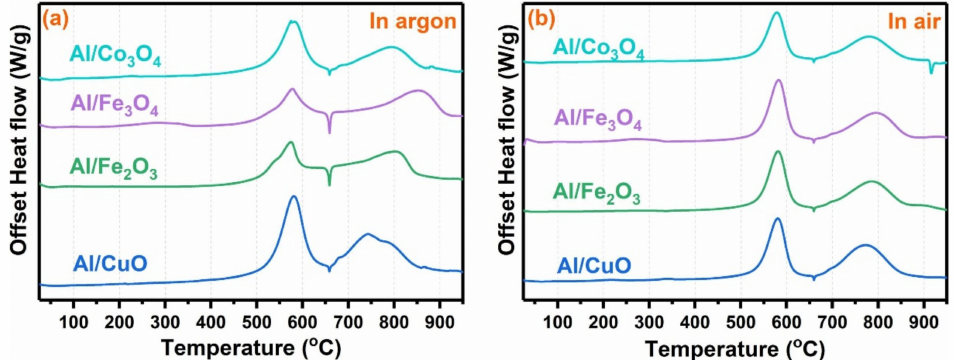
Figure 29. DSC traces collected for Al/CuO, Al/Fe 2 O 3 , Al/Fe 3 O 4 and Al/Co 3 O 4 as prepared and ramped in flowing Ar ( a ) and air ( b ) at 10 ◦ C/min. The y-axis values are offset. ( a , b ) Reproduced with the permission of ref. [145]. Copyright 2021, Chemical Engineering